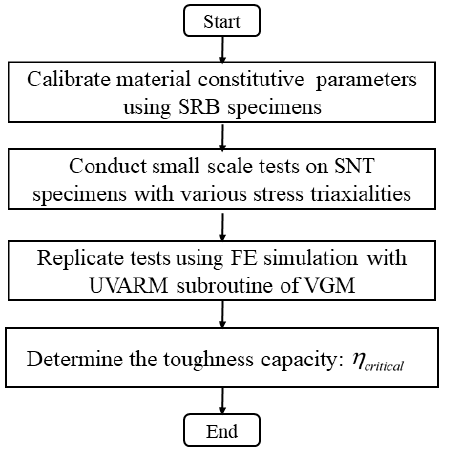
Figure 2. Flowchart of the calibration procedure for the